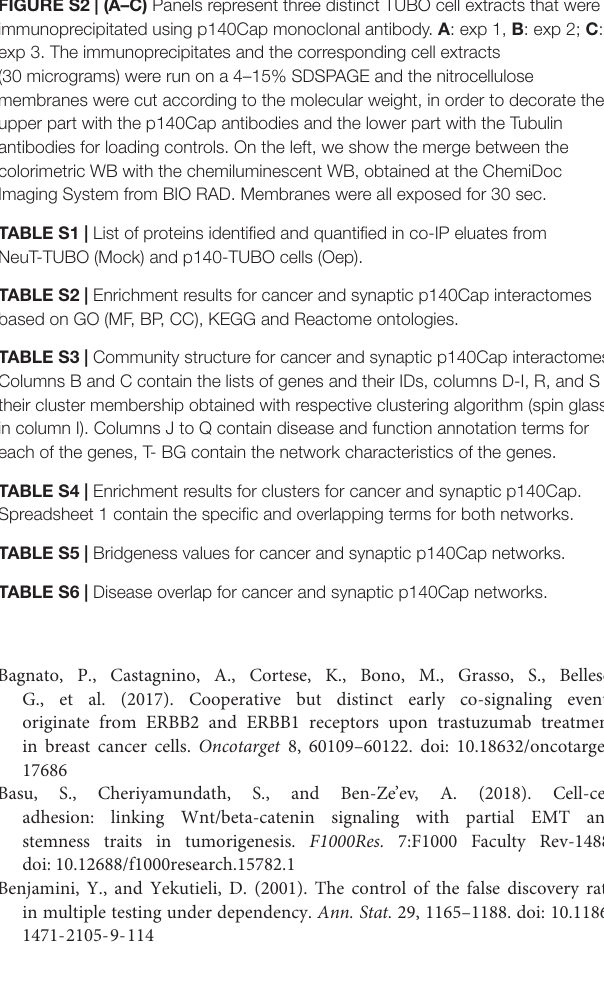
FIGURE S1 | In vitro characterization of p140Cap-TuBo cell line. FIGURE S2 | (A–C) Panels represent three distinct TUBO cell extracts that were immunoprecipitated using p140Cap monoclonal antibody. A : exp 1, B : exp 2; C : exp 3. The immunoprecipitates and the corresponding cell extracts (30 micrograms) were run on a 4–15% SDSPAGE and the nitrocellulose membranes were cut according to the molecular weight, in order to decorate the upper part with the p140Cap antibodies and the lower part with the Tubulin antibodies for loading controls. On the left, we show the merge between the colorimetric WB with the chemiluminescent WB, obtained at the ChemiDoc Imaging System from BIO RAD. Membranes were all exposed for 30 sec.